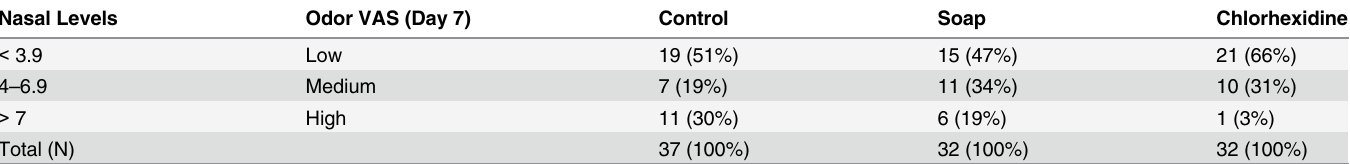
Table 1. Odor levels for each arm determined by blinded smellers on day 7.